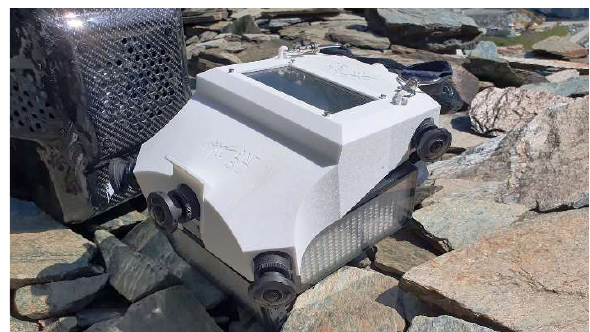
Figure 2. test paths acquired with the multi-camera on an orthographic view of the Milan’s